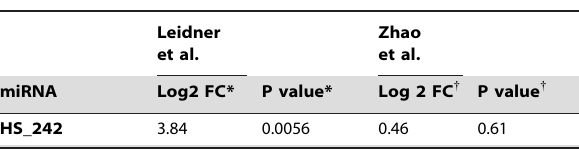
Table 5. Top 46 candidate miRNAs from current study compared in Zhao et al. dataset.